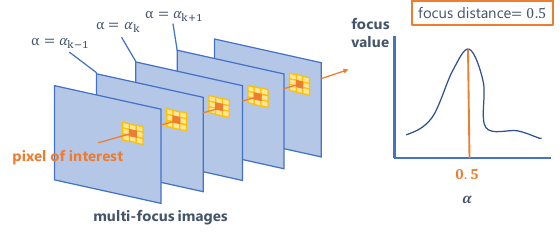
Figure 12. Focus distance